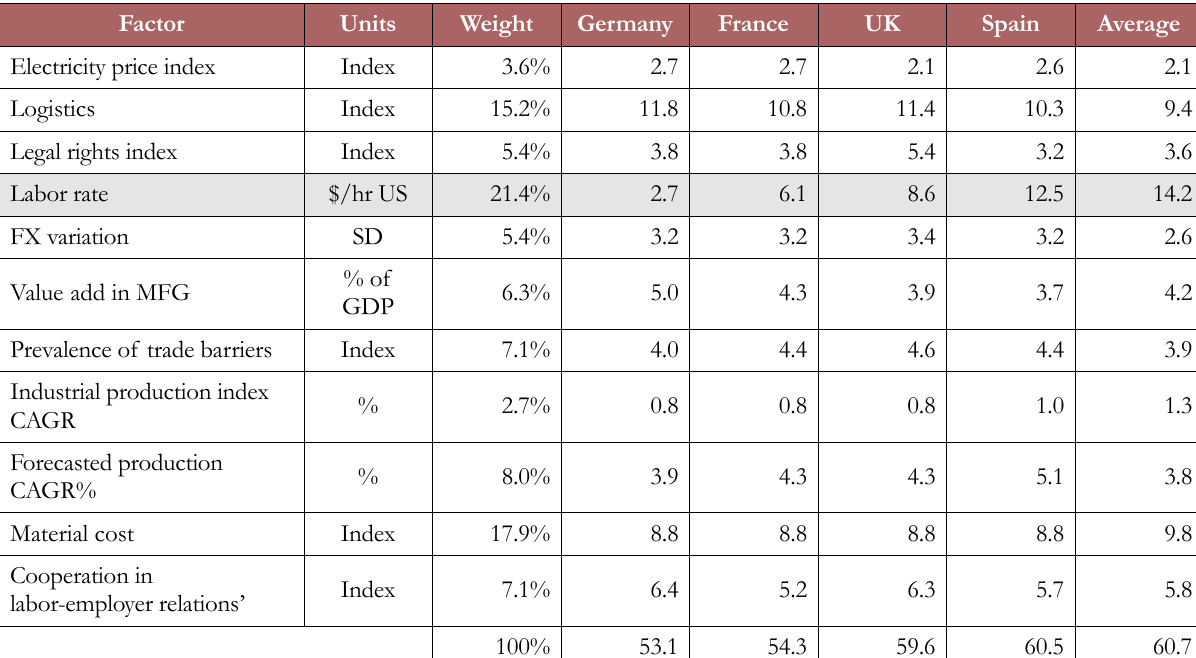
Table 13. Western Europe utility score